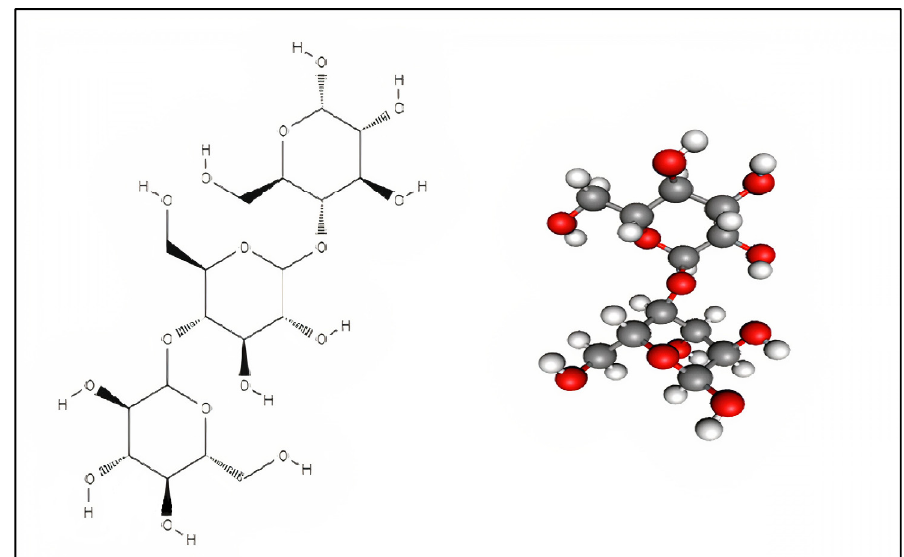
Figure 1. Basic structure of the starch molecule.